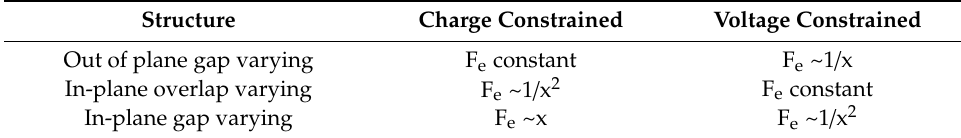
Table 7. Electrostatic force (Fe) variation for the three configurations. Structure